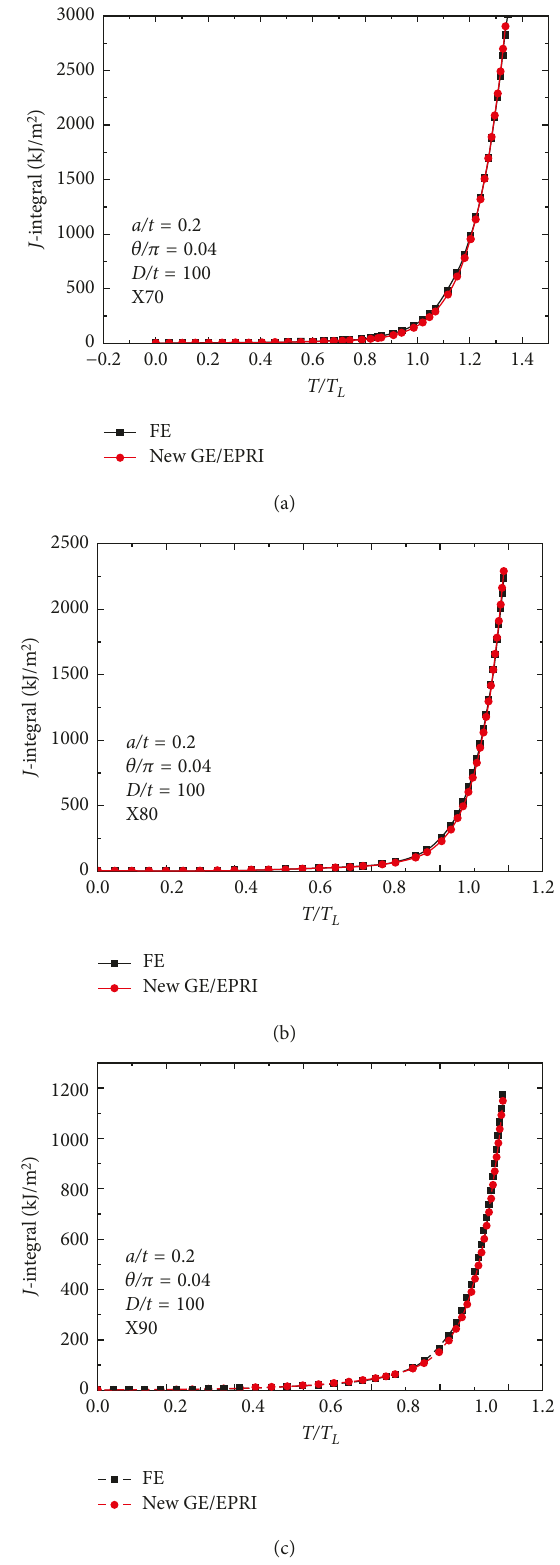
Figure 10: Comparison of J -integral estimated by using new elastic and plastic influence functions with FE results for thin-walled pipes under tension having D / t (b) X80; (c)